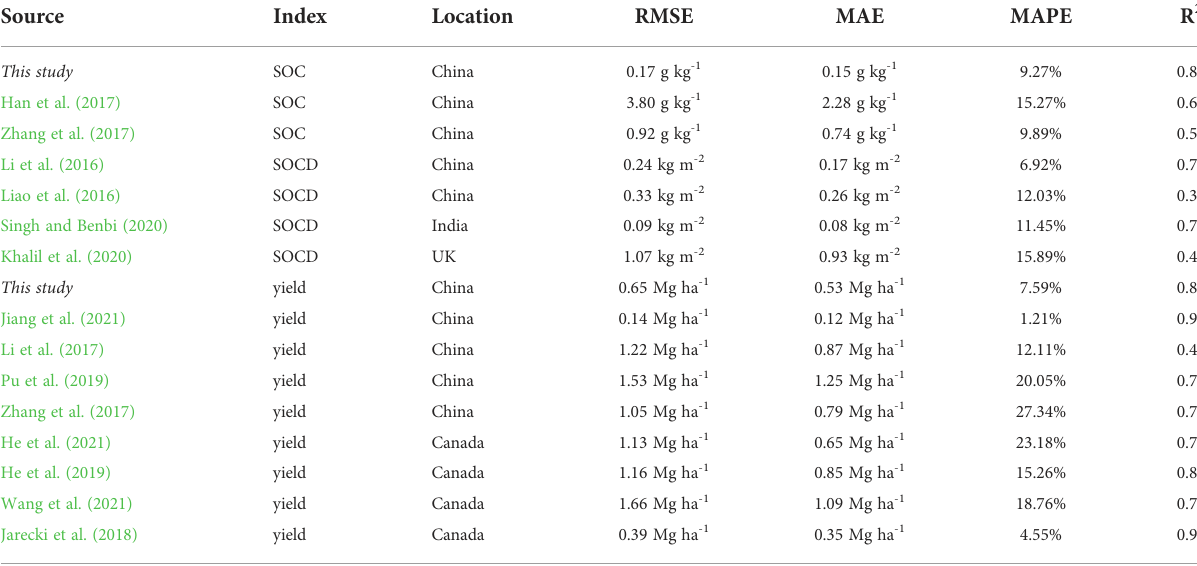
TABLE 4 Comparison of the DNDC model ’ s yield and soil organic carbon (SOC) prediction accuracies between this study and other studies found in the recent literature.